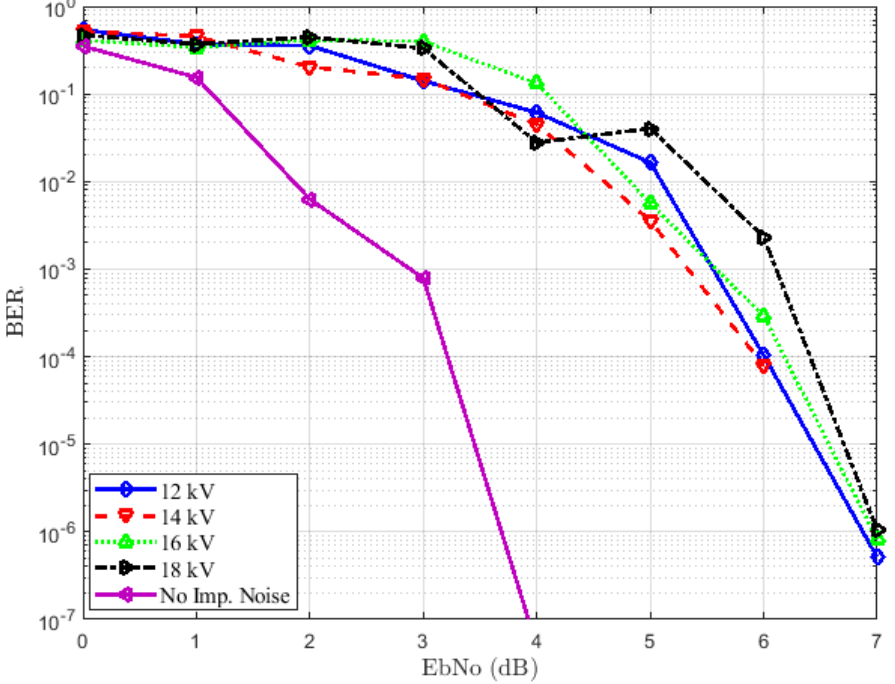
Figure 10. BER performance for different voltages in the LOS